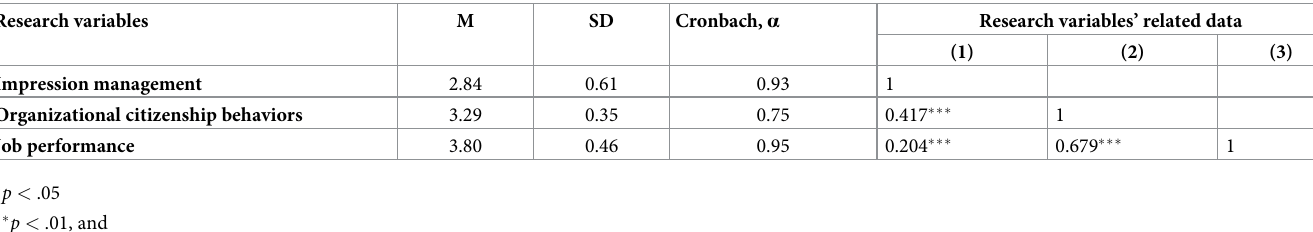
Table 1. Descriptive statistics, correlation coefficients, and reliability coefficient of the research